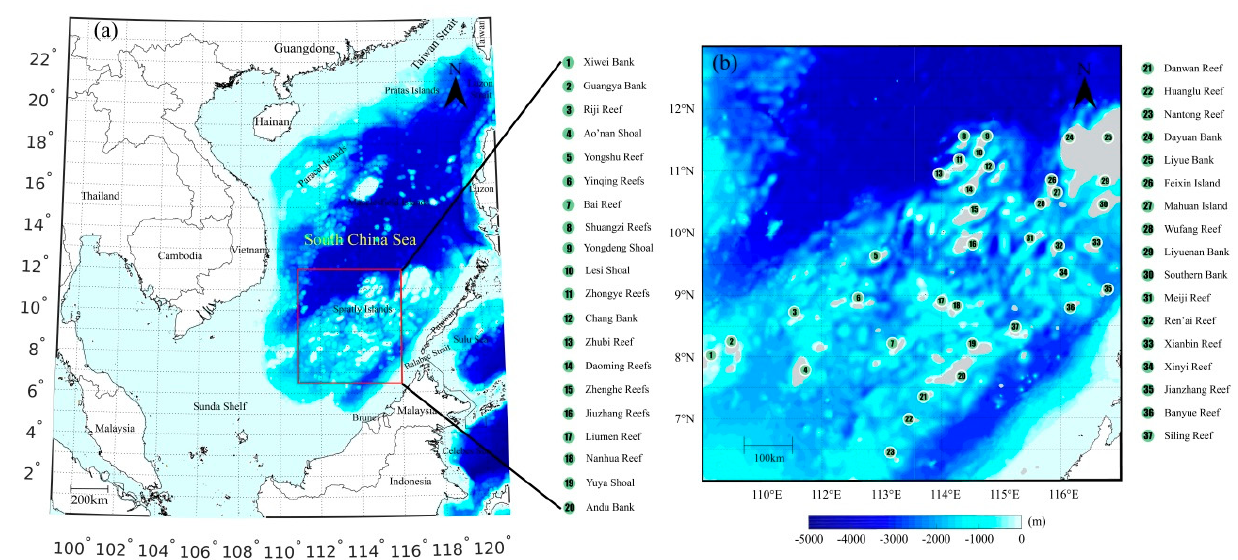
Figure 1. ( a ) Study area and ( b ) the primary islands of the Spratly Islands. The geographical coordinates are expressed in the Plate Carrée projection.